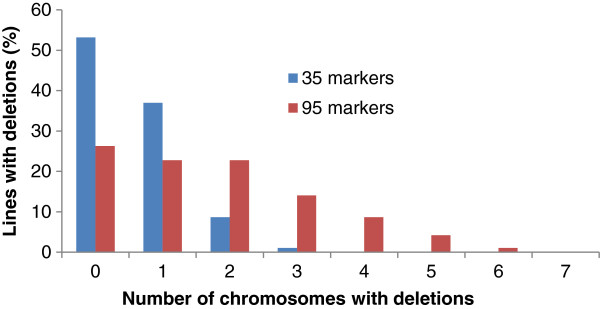
Effect of number of markers in detecting RH lines with multiple chromosome breaks. Percentage of RH1 lines with deletions for multiple chromosomes identified using two sets of different numbers of markers. The results are based on the screening of 92 lines.